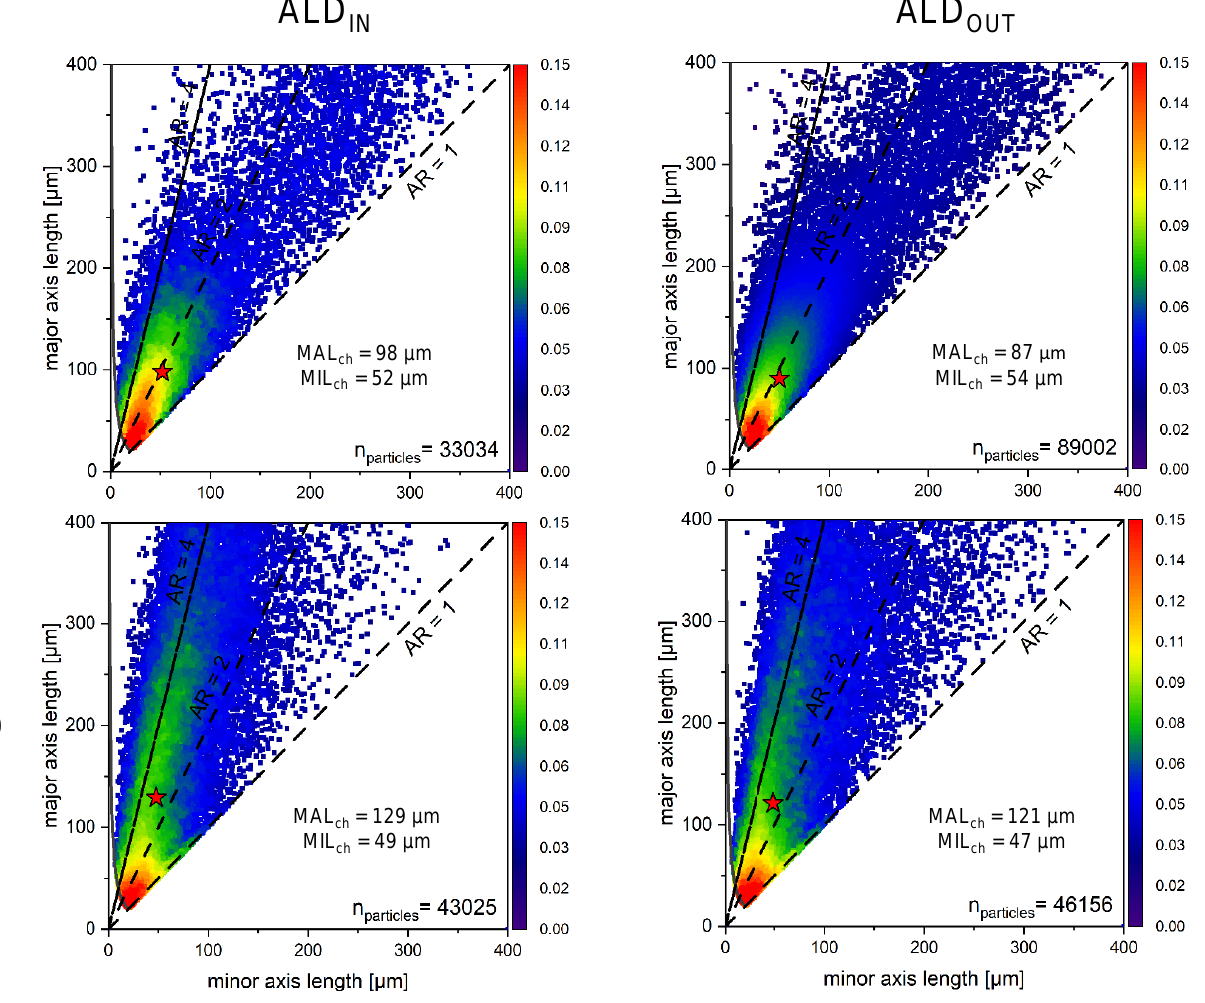
Figure 8. Axis length distribution in the inlet suspension (ALD IN , left) and washed product particles after drying (ALD OUT , right): upper half—for cuboid-shaped particles; lower half—for needle-shaped particles.